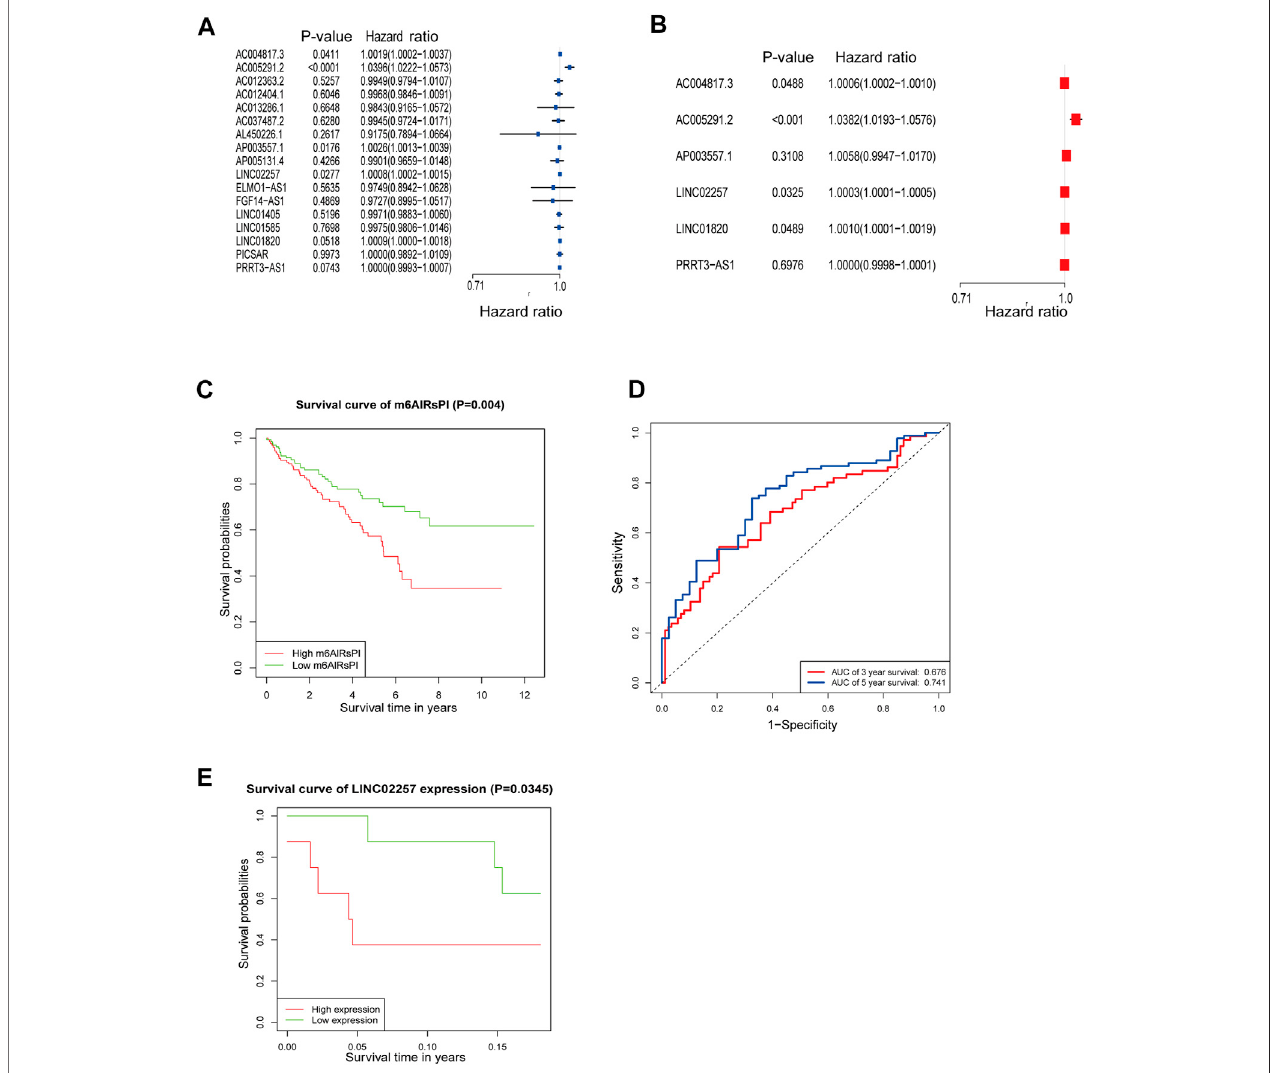
FIGURE 5 | Internal and external validation for m6AlRsPI. (A) The result of univariate Cox regression analysis for m6A-lncRNAs associated with M stage in gray module in the testing cohort, shown by forest plot. (B) The outcome of multivariate Cox regression analysis for hub lncRNAs with p < 0.05 within the univariate Cox regression analysis. (C) KM survival analysis for m6AlRsPI constructed by testing cohort. (D) In testing cohort, ROC curve for predicting 3- and 5-year survival. (E) Validation of the survival signature for LINC02257 within GEO